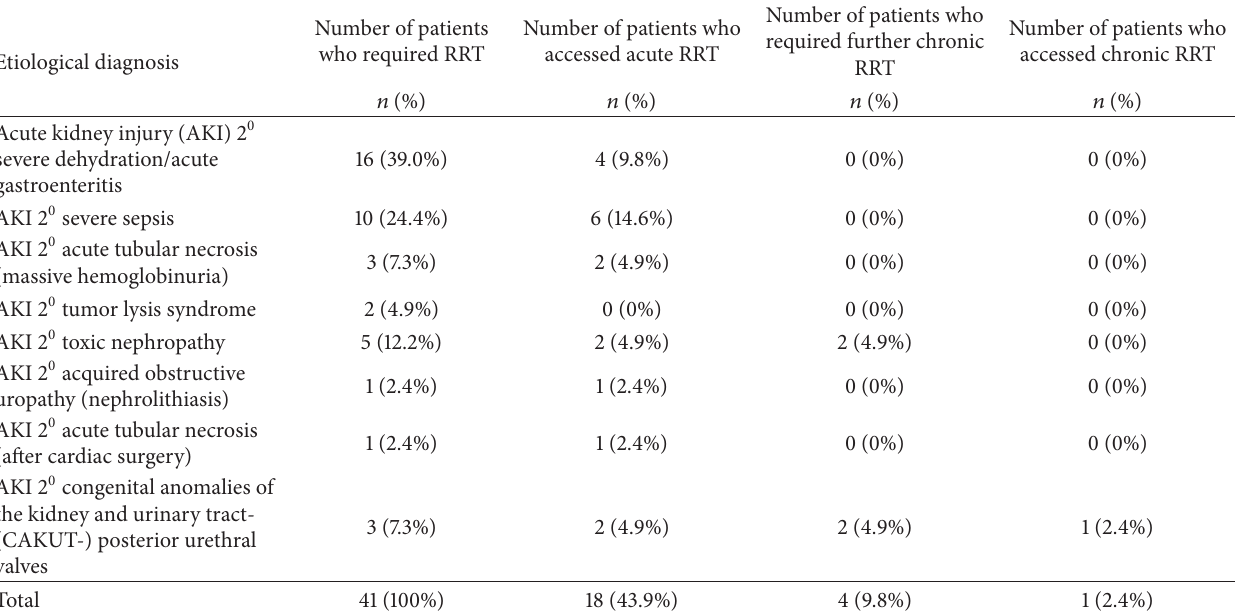
Table 3: Primary etiological diagnosis in AKI patients who required